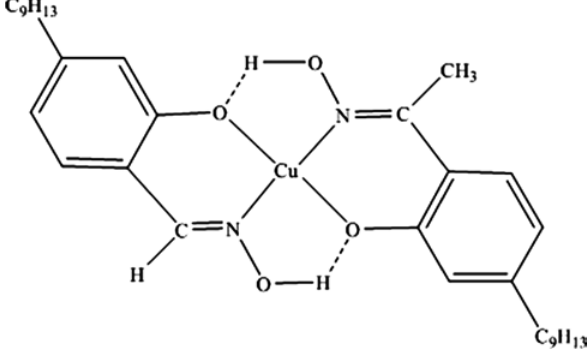
Figure 2: The structural formula of the product after chelating